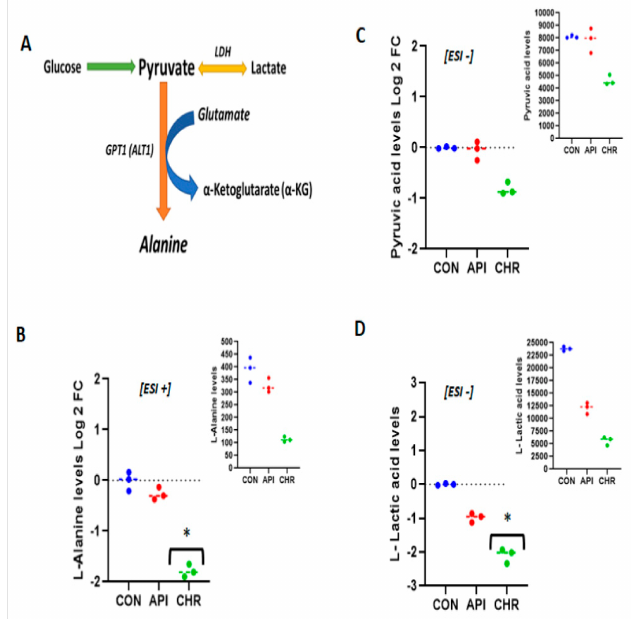
Figure 8. Regulation of alanine metabolism by chrysin: The schematics for alanine regulation in non- hepatic cells are represented. ( A ) The source of alanine is from either of the glucose metabolites—pyruvate or lactate. The formed alanine is then effluxed of the cell. ( B ) Represents L-alanine raw values (upper insert) and log2 fold change values. The log2 fold change values for pyruvic acid and lactic acid, which are the acidic forms for pyruvate and lactate with their respective raw values (inserts), are represented in Figure 3 panel ( C , D ), respectively * p < 0.05.